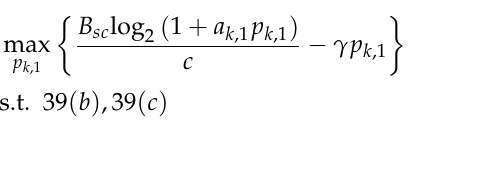
Algorithm 3 The Dinkelbach’s